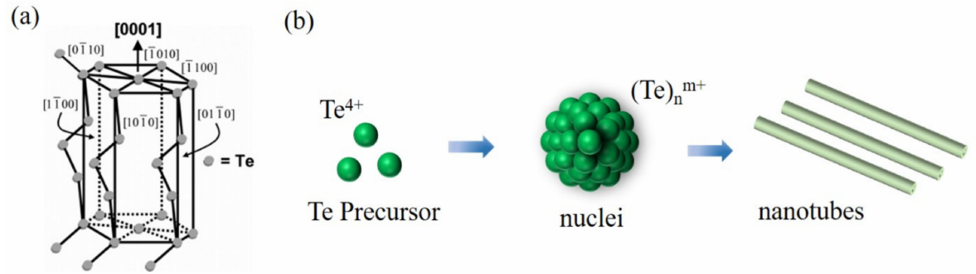
Figure 4. ( a ) Schematic representation showing the hexagonal crystal structure of tellurium. Reprinted with permission from [10]. Copyright 2006, American Chemical Society, Washington, DC, United States. ( b ) A schematic illustration of the reaction pathways that lead to Te